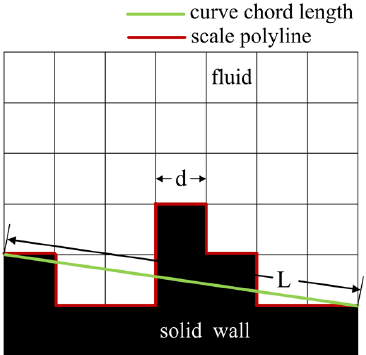
Figure 3. Modified model of fractal dimension.